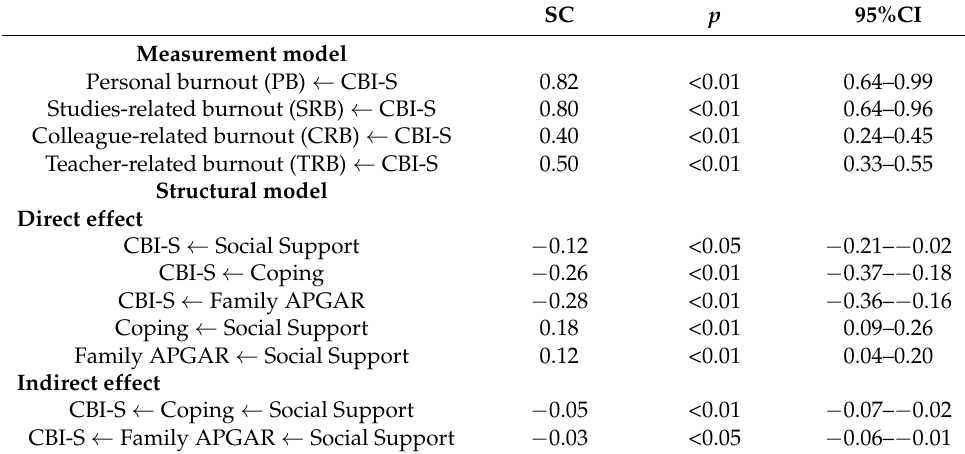
Table 2. Standardized coefficient (SC), 95% confidence interval (95%CI), and p -value of the structural equation